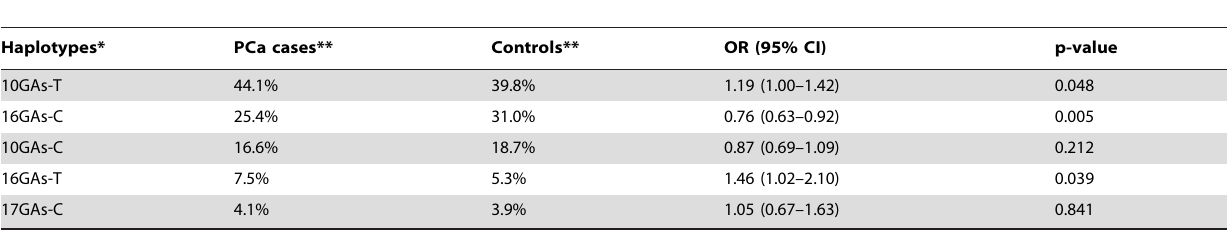
Table 4. Haplotype frequencies and their association with prostate cancer risk (haplotype STRP1- rs10948059).